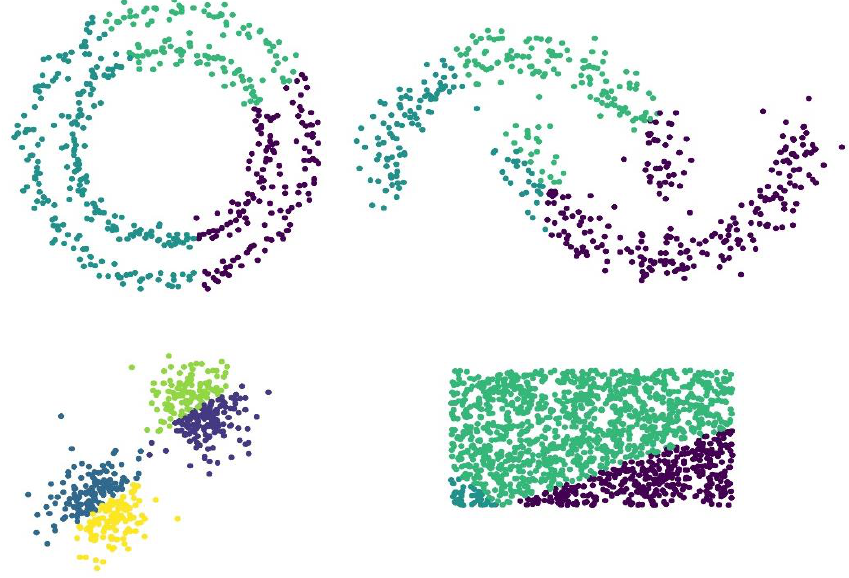
Figure 3. An example of k -means clustering. Table 1. Results of the study of clustering